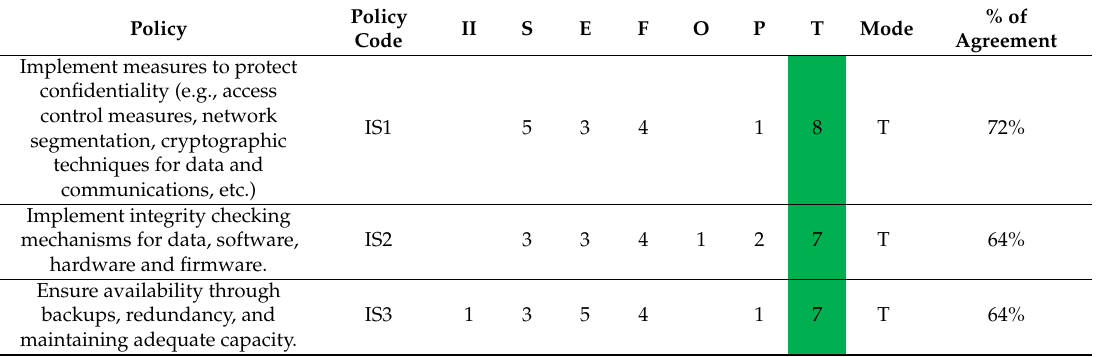
Table 21. Information security policies’ progression